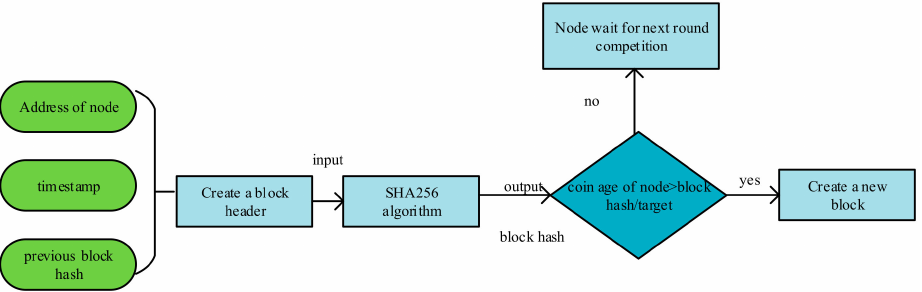
Figure 8. The working principle of the PoS